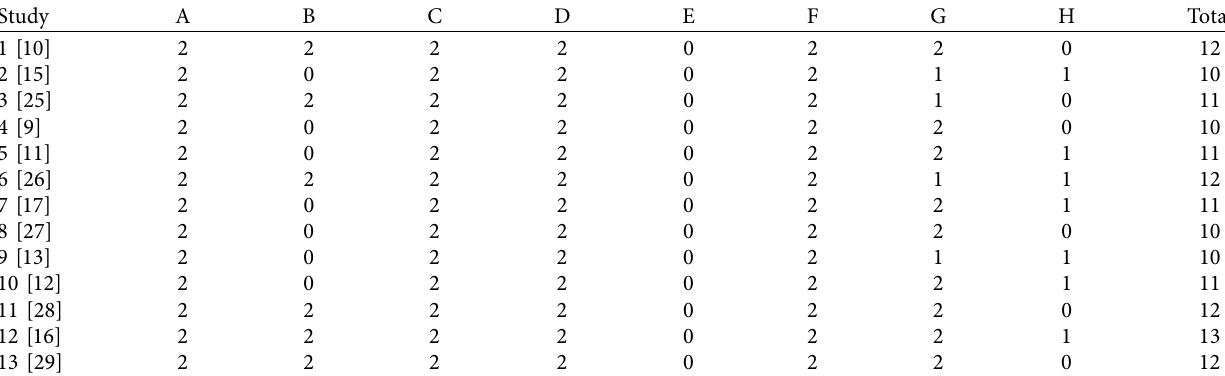
Table 1: MINORS scores of eligible studies (sort by study year and